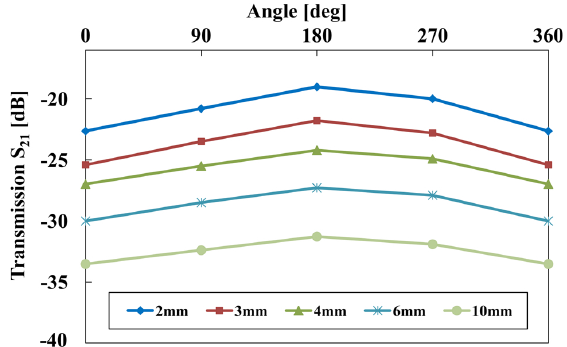
Figure 10. Measured angular transmission amplitude S 21 variation between the coupler elements at di ff erent